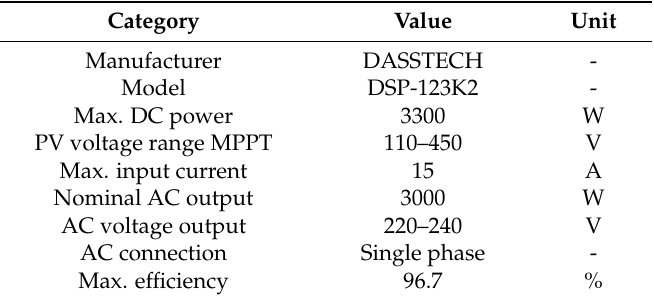
Table 4. Specifications of the PV